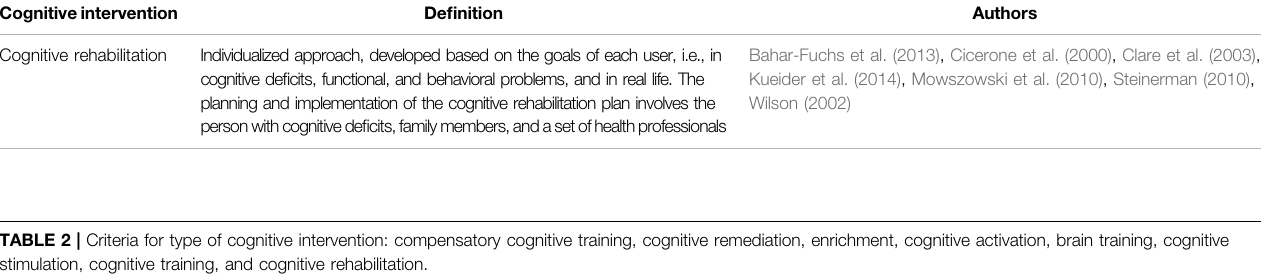
TABLE 2 | Criteria for type of cognitive intervention: compensatory cognitive training, cognitive remediation, enrichment, cognitive activation, brain training, cognitive stimulation, cognitive training, and cognitive rehabilitation. Cognitive